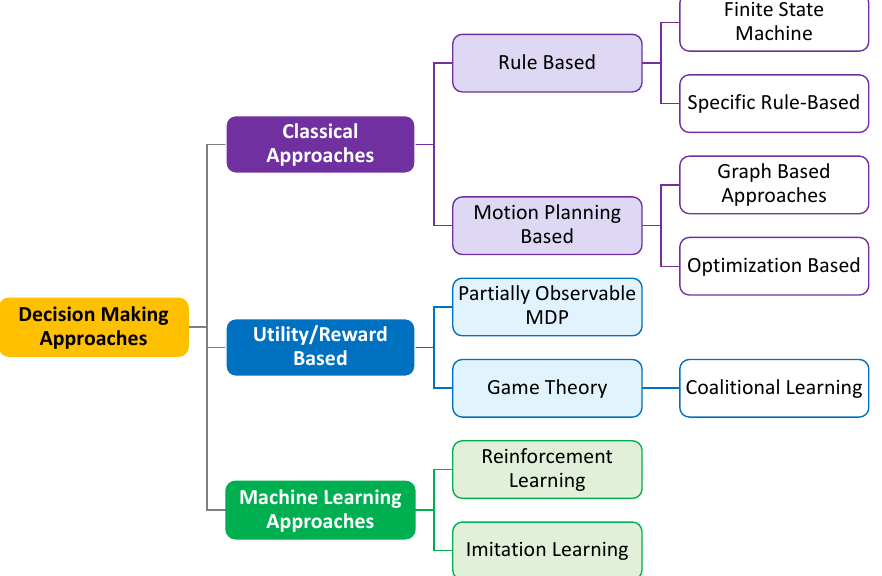
Figure 3. Categorization of Decision-Making Approaches for Autonomous